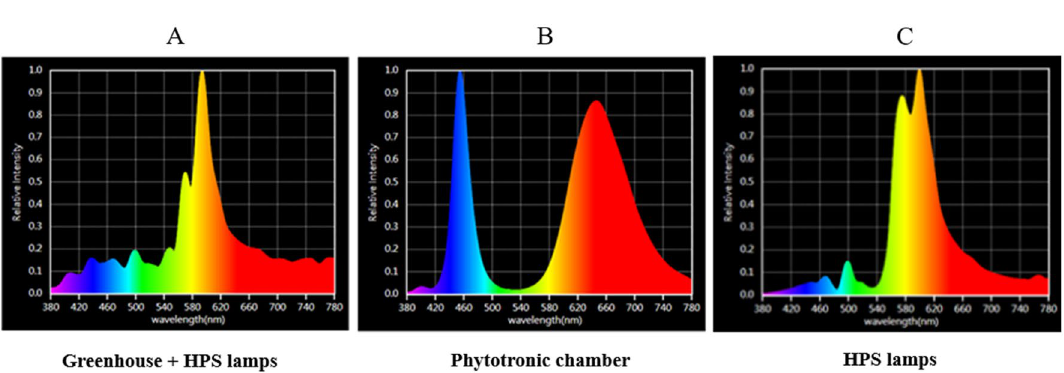
Figure 4. Light spectrum in a greenhouse under solar light supplemented with HPS Agro Phillips lamps ( A ; control), phytotron chamber with LED light ( B ), and the light spectrum emitted by solo HPS ( C